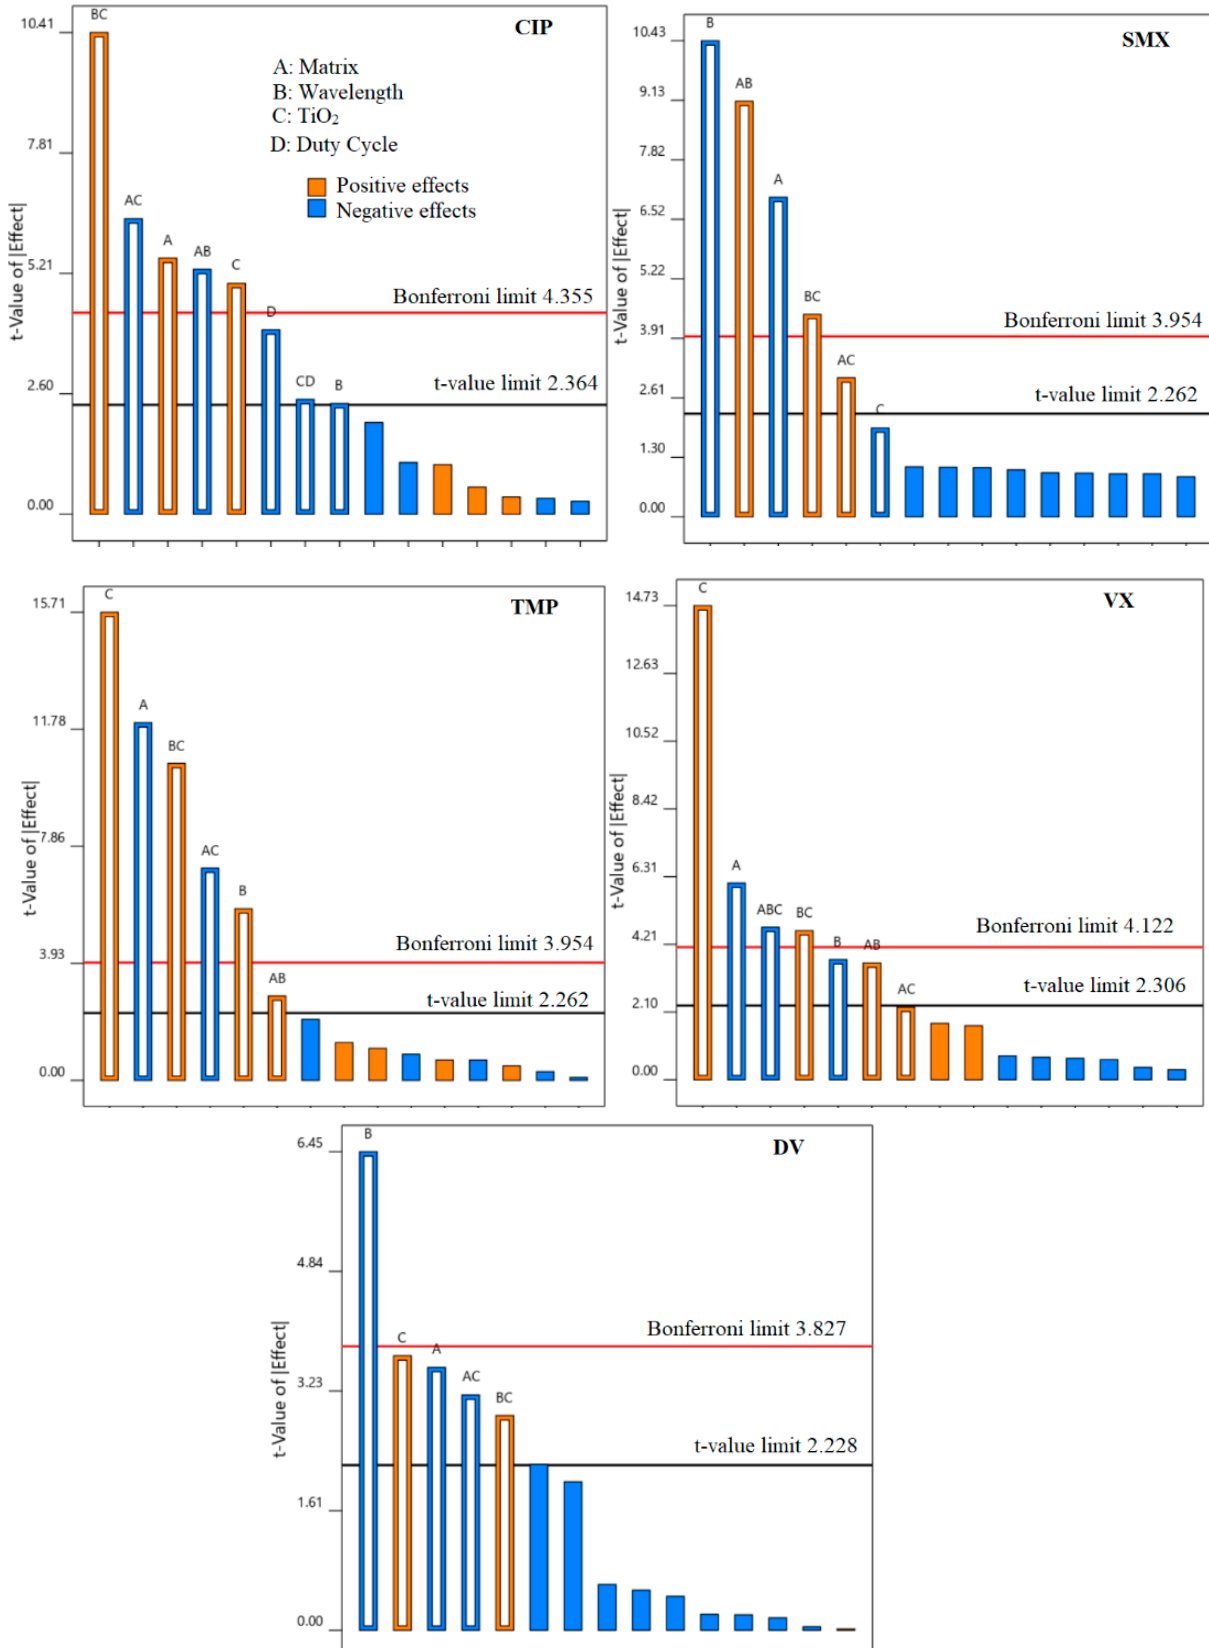
Figure 2. Pareto charts and significant effects (above Bonferroni limit) for k app . BC, significant for all PhACs, represents the combined impact of wavelength (B) and catalyst presence (C). The best results were obtained with the catalyst combined with UV- A or when no catalyst was used in the presence of UV-C. This is explained by the fact that, on the one hand, UV-A rays were not able to degrade the tested PhACs by means of pho- tolysis alone (except CIP). On the other hand, UV-C rays are highly capable of photolytic degradation but suffer from a strong screening effect in the presence of the catalyst. The overall results indicate that the enhancement obtained by the presence of the catalyst, when UV-C was used, did not compensate for the photo absorption losses by the system. The influence of the matrix (A) was significant in all the cases. Tap water contains many ions (Table S1) which can influence the degradation positively or negatively [16]. The difference in the pH between tap and MQ water can also impact the degradation rates [63]. All compounds degraded slower in tap water due to the presence of scavengers. The only exception was CIP, due to the already mentioned more reactive neutral ionic state of this molecule at pH > 6.08 (see Sections 3.1 and 3.4). Tap water could simulate better than MQ a post-treatment for specific water treatment and reuse goals [34,37]. The duty cycle (D) had a significant impact only on the k app of CIP. This result is in accordance with Figure 1, since CIP was the compound with the fastest reactivity towards ROS in the mixture, and the radical enhancement, caused by the lower duty cycle, should